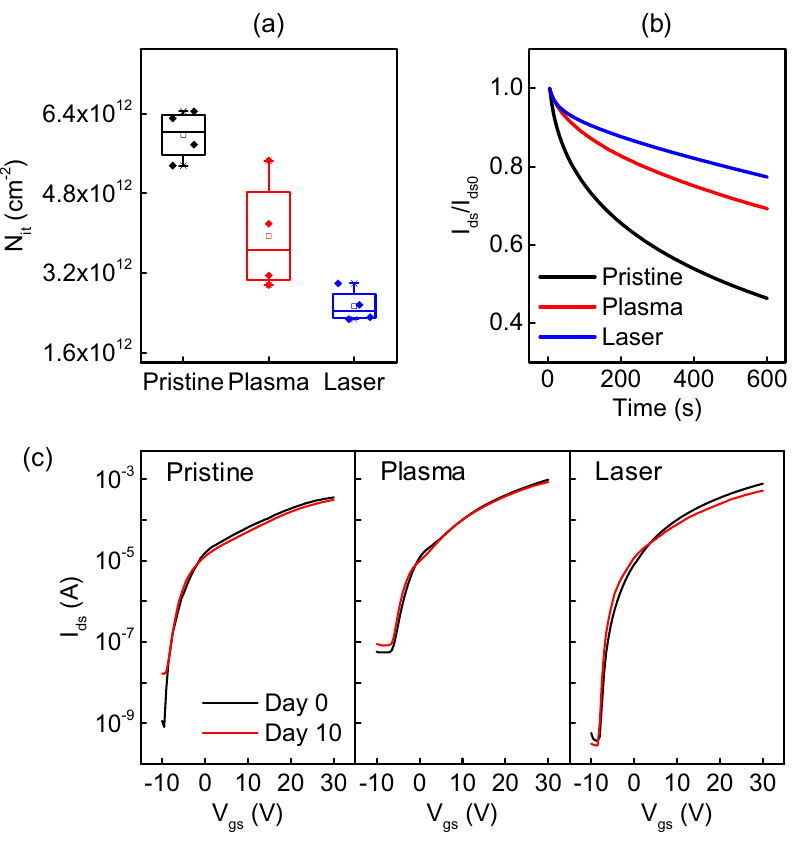
Figure 4. Multi-stacked IZO TFTs ( a ) interface trap charges, ( b ) stress time stability characteristics in pristine, plasma, and femtosecond laser pre-annealing and ( c ) transfer curves of devices compared after 10 days of storage under ambient conditions.